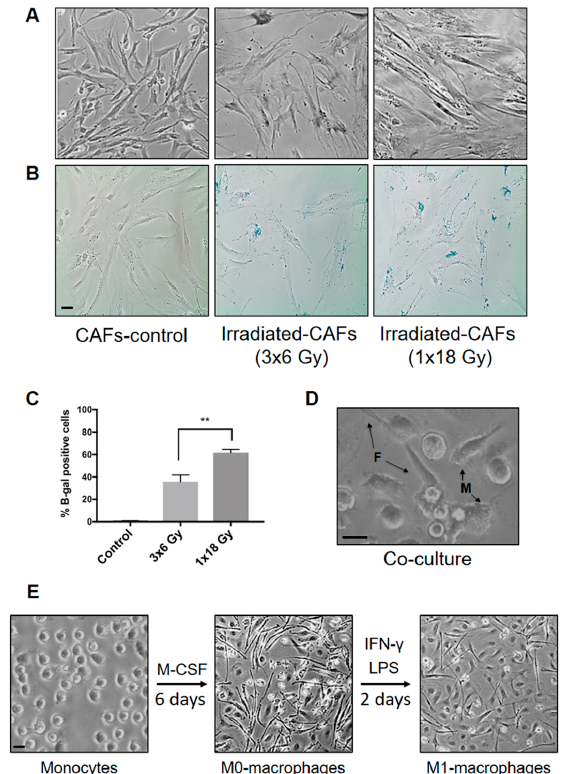
Figure 1. ( A ) Cancer-associated fibroblasts (CAF) cultures and senescence induction by ionizing radiation. Culture-expanded human lung tumor CAFs were divided into three groups and irradiated with a clinical linear accelerator. One group was irradiated once with high-dose radiation (1 × 18 Gy) and another with three daily doses of 6 Gy. ( B ) Radiation-induced senescence was demonstrated by a β -galactosidase assay, where β -gal positive cells develop blue color. ( C ) Percentage of β -galactosidase positive cells in each condition was calculated from two di ff erent donors. Student’s t -test and p -values were determined between the two iCAF-groups. ( D ) Photomicrograph showing CAFs and macrophages inco-culture. ( E )Macrophageisolationandpolarization: Monocytes(CD14 + )wereisolatedfromPBMCs and incubated with M-CSF to induce macrophage di ff erentiation (M0-phenotype). Monocyte-derived M0-macrophages were further polarized into M1-macrophages by LPS and IFN- γ . Scale Bars = 15 µ